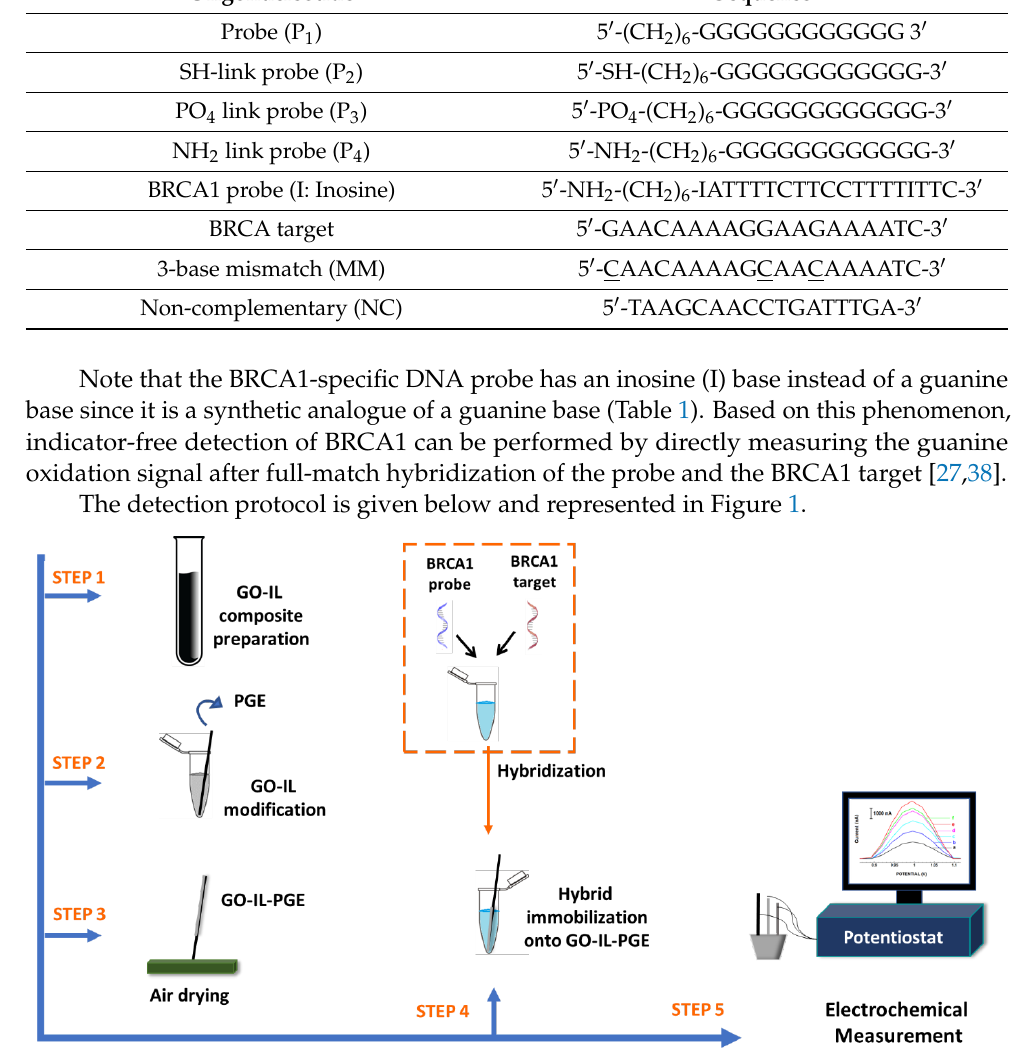
Figure 1. The schematic view of the experimental procedure followed for electrochemical sensing of BRCA1 gene using GO-IL-PGEs.